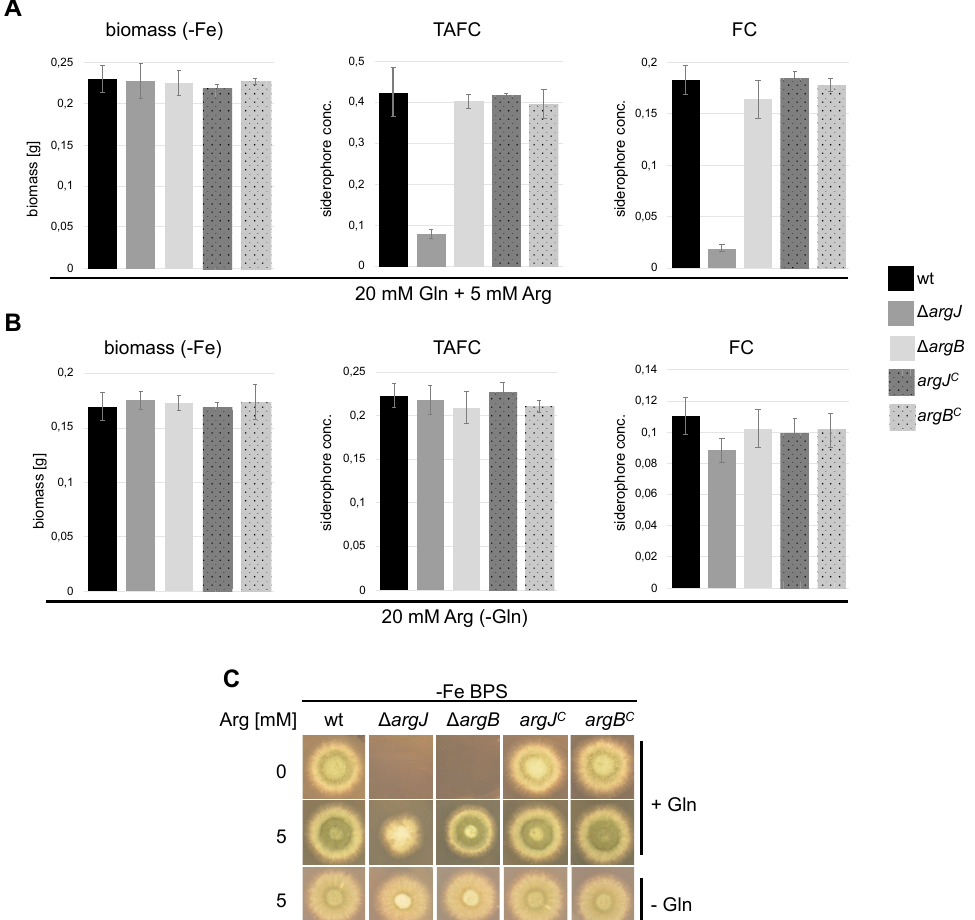
Figure 3. Lack of ArgJ, but not ArgB, impairs adaption to iron starvation with glutamine but not with arginine as major nitrogen source. ( A ) wt, ∆ argJ , and ∆ argB were grown for 22 h at 37 ◦ C in liquid minimal medium under iron-depleted conditions (-Fe) in the presence of 5 mM arginine and 20 mM glutamine. ∆ argJ displayed significantly decreased production of the extracellular (TAFC) and intracellular (FC) siderophores (TAFC; p = 0.0002 vs. wt; FC; p < 0.0001 vs. wt) while ∆ argB showed wt-like siderophore production. ( B ) Iron-starved media (-Fe) with 20 mM arginine as sole nitrogen source (-Gln) rescued the siderophore production defect of ∆ argJ (TAFC, p = 0.354 wt vs. ∆ argJ ; FC, p = 0.024 wt vs. ∆ argJ ). ( C ) Wt, ∆ argJ, and ∆ argB were point inoculated on solid minimal medium containing 0.2 mM of the iron chelator BPS (-Fe), 5 mM arginine, 20 mM glutamine, or no glutamine (-Gln). Growth was scored after 48 h at 37 °C. In (A,B), mean values of three replicates ± standard deviations are shown.